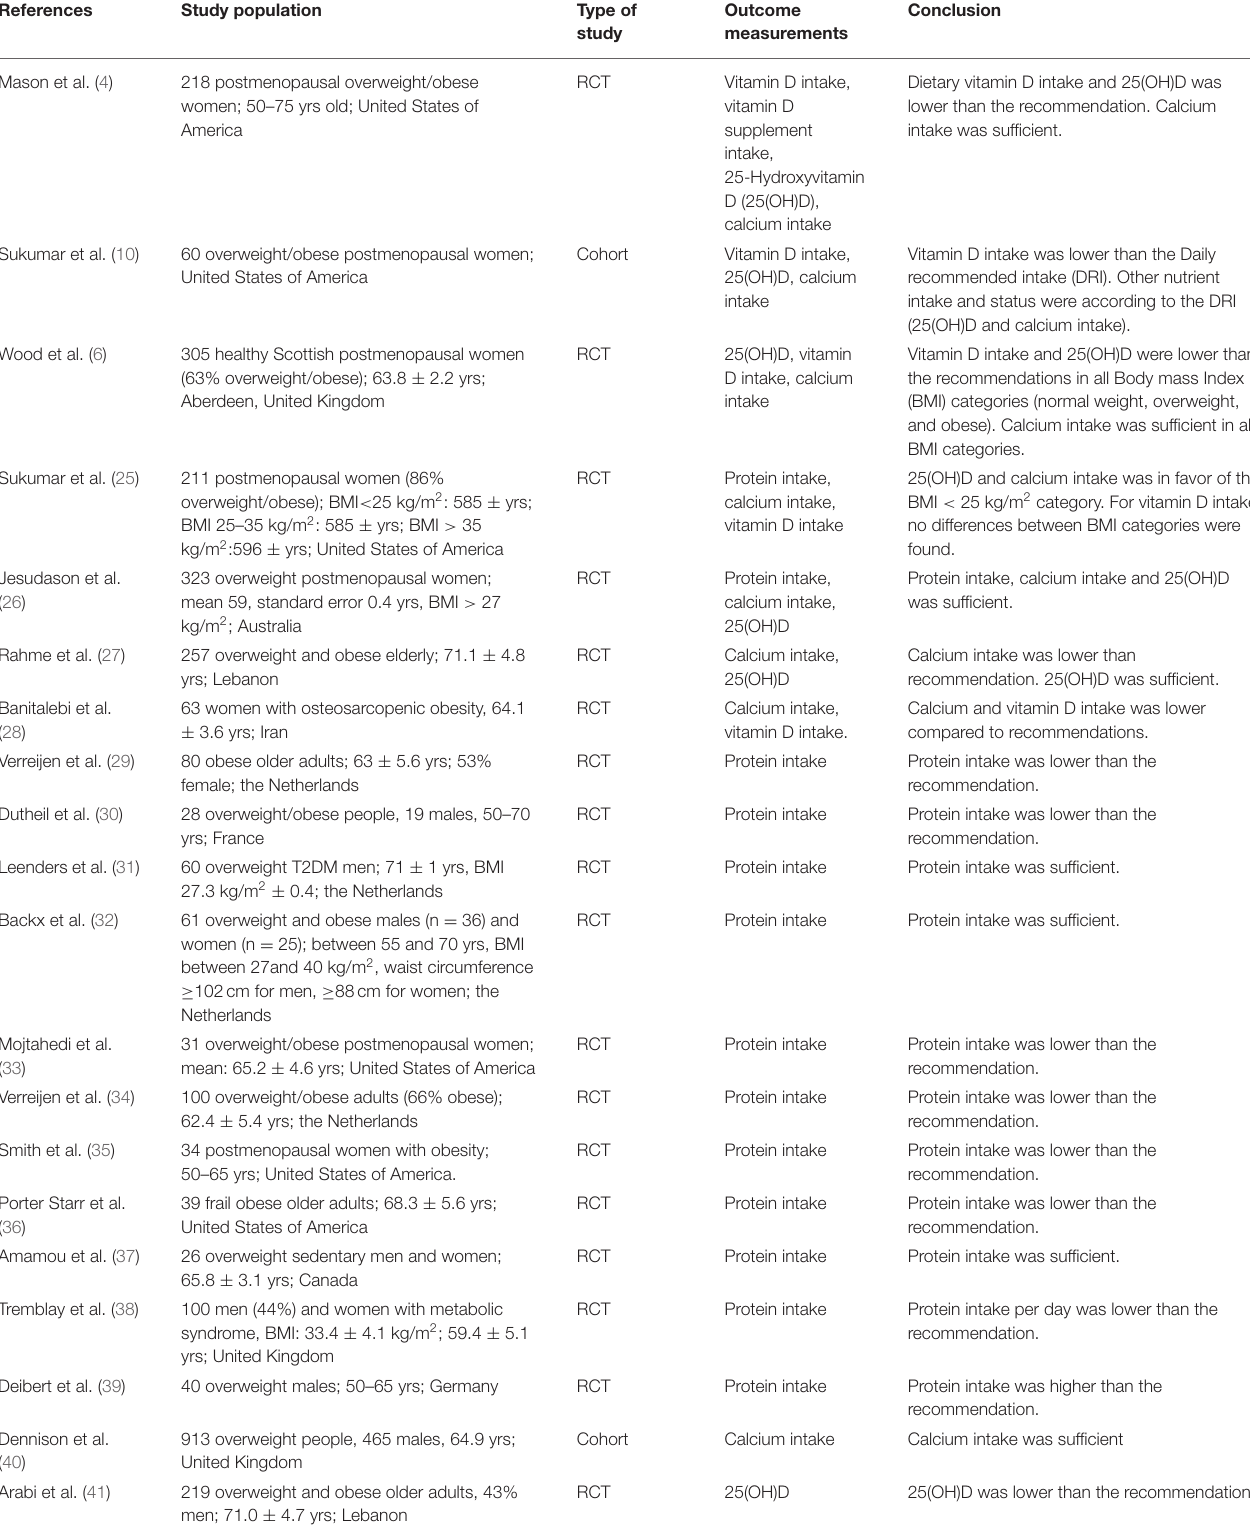
TABLE 2 | Overview of studies included in the systematic review and